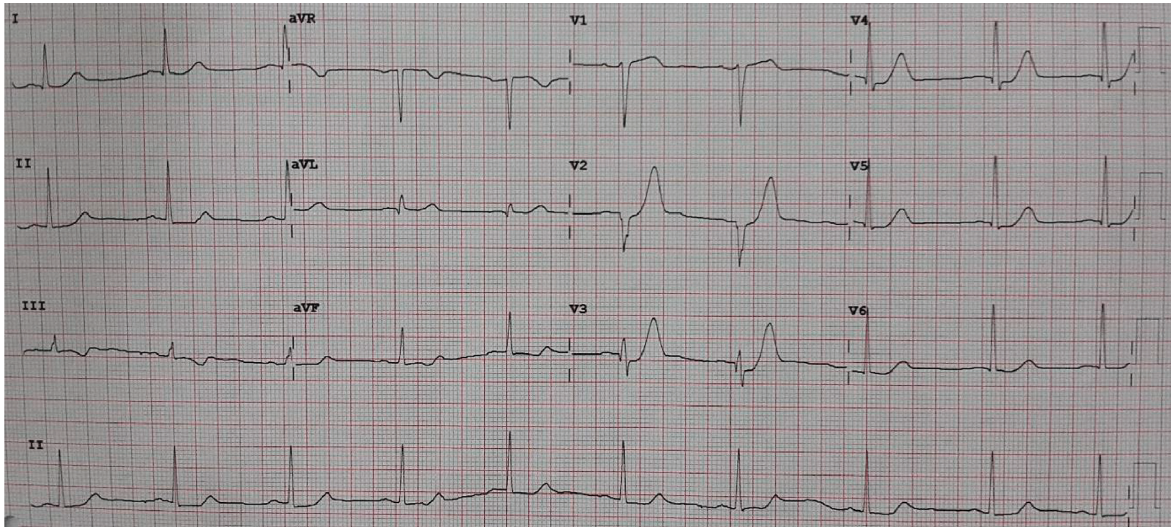
Figure 1: Initial ECG showing > 1 mm upsloping STdepression with symmetric tall Tin lead V